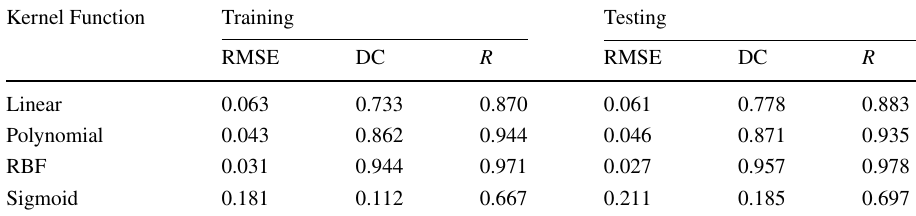
Fig. 4 Distribution diagram of the observational-computational values in training and testing stages of MLP and RBF models Table 4 Statistical parameters of the SVM model with different